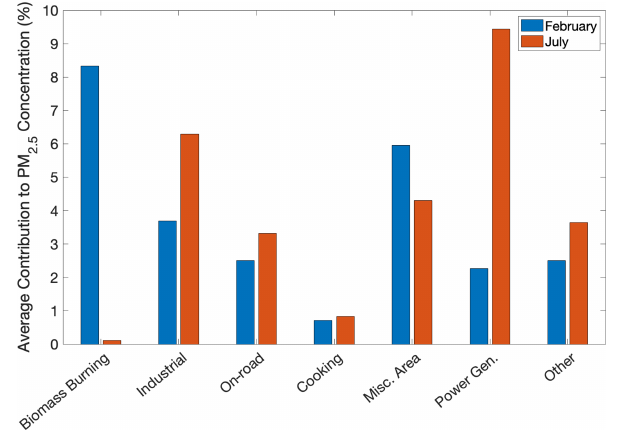
Figure 11. Relative contributions of local sources to average pre- dicted total PM 2 . 5 concentrations in downtown Pittsburgh during February and July 2017.